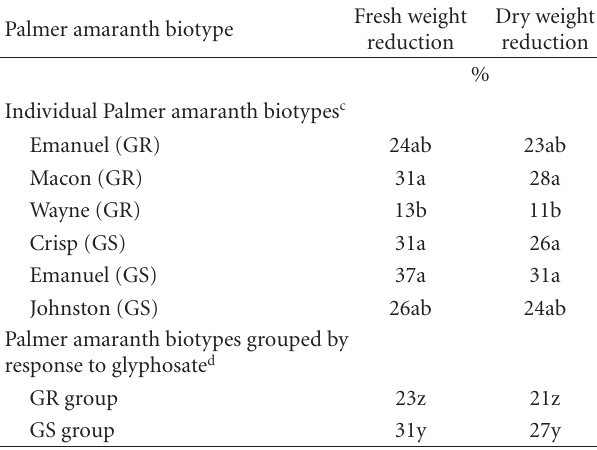
Table 1: Percent reduction in soybean fresh weight and dry weight at harvest (40 days after emergence) caused by early season inter- ference by Palmer amaranth in greenhouse experiment. a,b Palmer amaranth